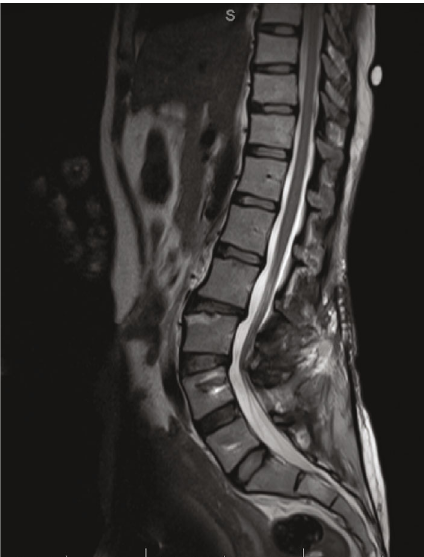
Figure 6: MRI was done 6 months postoperative fi xation which revealed normal neurological strutures with no evidence of paraspinal cold abscess